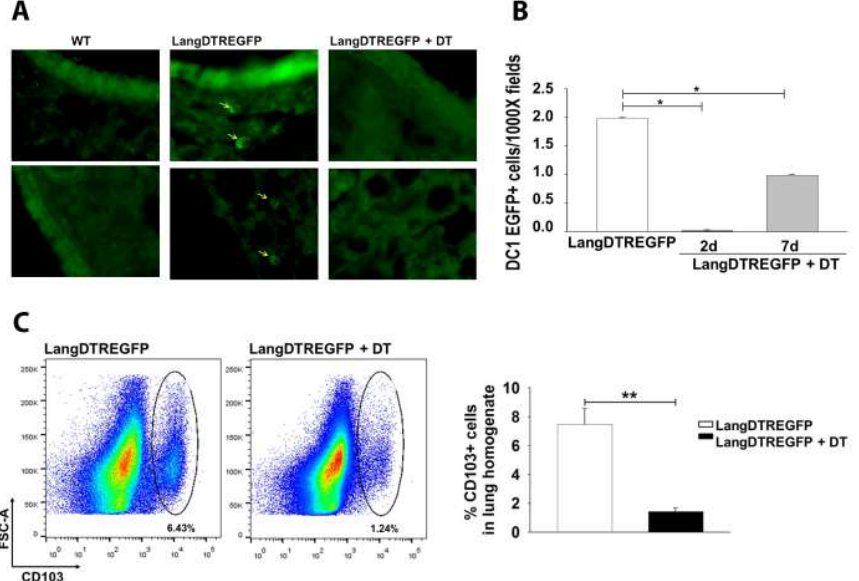
Figure 1. Conditional depletion of pulmonary langerin-expressing DC1 (LangDC1) after diphtheria toxin (DT) treatment of LangDTREGFP mice. ( A ) Representative microphotograph of immunofluorescence analysis of lung cryosections from untreated (saline) WT and LangDTREGFP mice or DT-treated (2 days post DT ) LangDTREGFP animals. Arrows: langerin-expressing (EGFP+) cells. ( B ) Total number of EGFP+ cells counted per high-powered field within lung cryosections from untreated (white bars) or DT-treated LangDTREGFP mice, at 2 (black bars) or 7 (gray bars) days after DT administration. Data are expressed as mean ± SEM; bars represent data from two tissue samples from each animal analyzed at a magnification of 1000 X (three animals per group). * p ˂ 0.001. ( C ) Flow cytometry analysis showing representative dot plots of pulmonary DC1 (CD103+ gated on CD45+ CD11c+ live lung cells) after 4 days of saline or DT administration. The bar graph shows percentages of pulmonary DC1 (CD103+ CD45+ CD11C+ cells) from untreated (white bar) or DT-treated (black bar) LangDTREGFP mice. Data are expressed as mean ± SEM from triplicates of pooled lung cells ( n = 3 animals per group) and representative of two independent experiments. ** p < 0.026. All data were analyzed with Student’s t -test or ANOVA. DC1: conventional type 1 dendritic cells; DT: diphtheria toxin; WT: wild